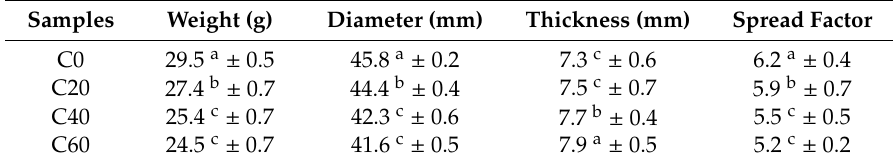
Table 6. Physical qualities of cookies fortified with sorghum–termite